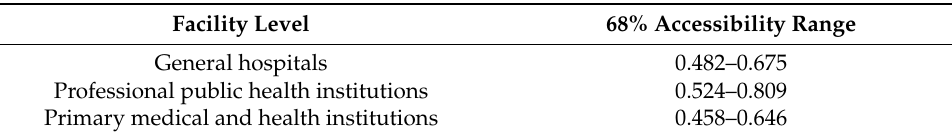
Table 17. 68% accessibility range of medical and health facilities